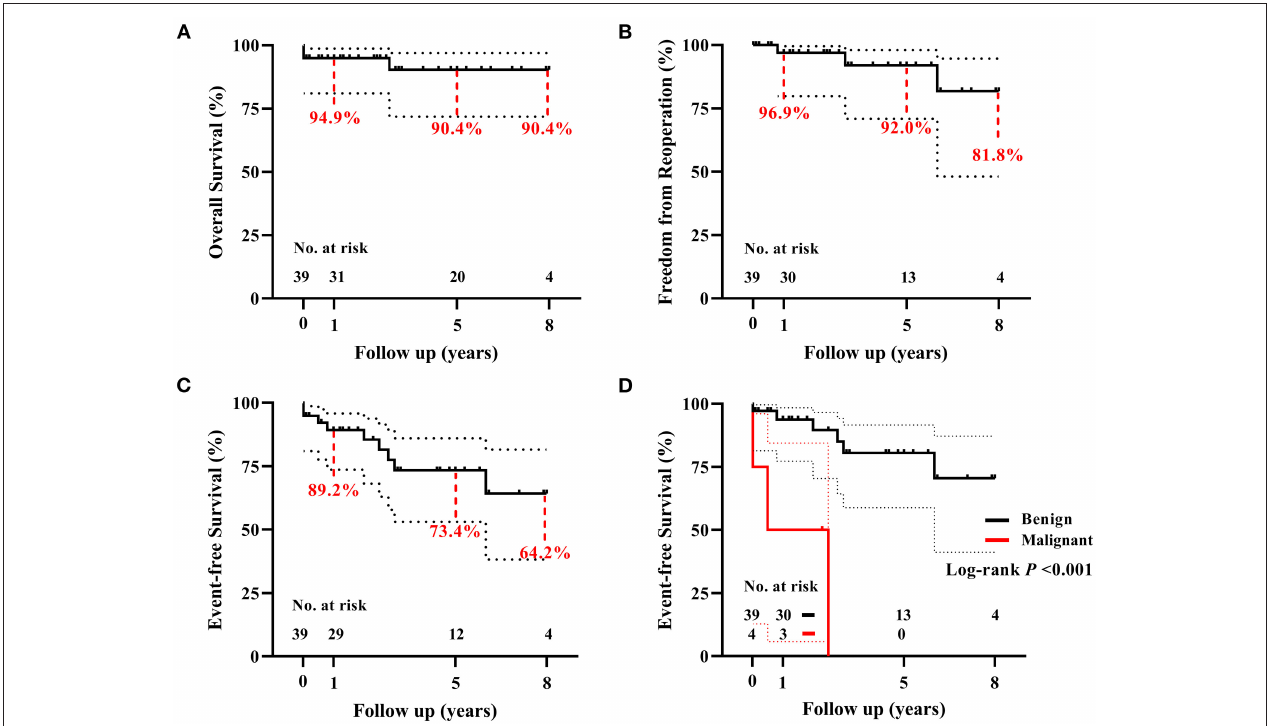
FIGURE 4 | The Kaplan–Meier analyses for 39 children with primary cardiac tumors. (A) The overall survival, (B) the freedom from reoperation, and (C) the event-free survival following surgical resection of primary cardiac tumors. (D) Patients with benign tumors have a significantly higher event-free survival rate than patients with malignant tumors. Curves were truncated when the number at risk is less than 10% of the original cohort.